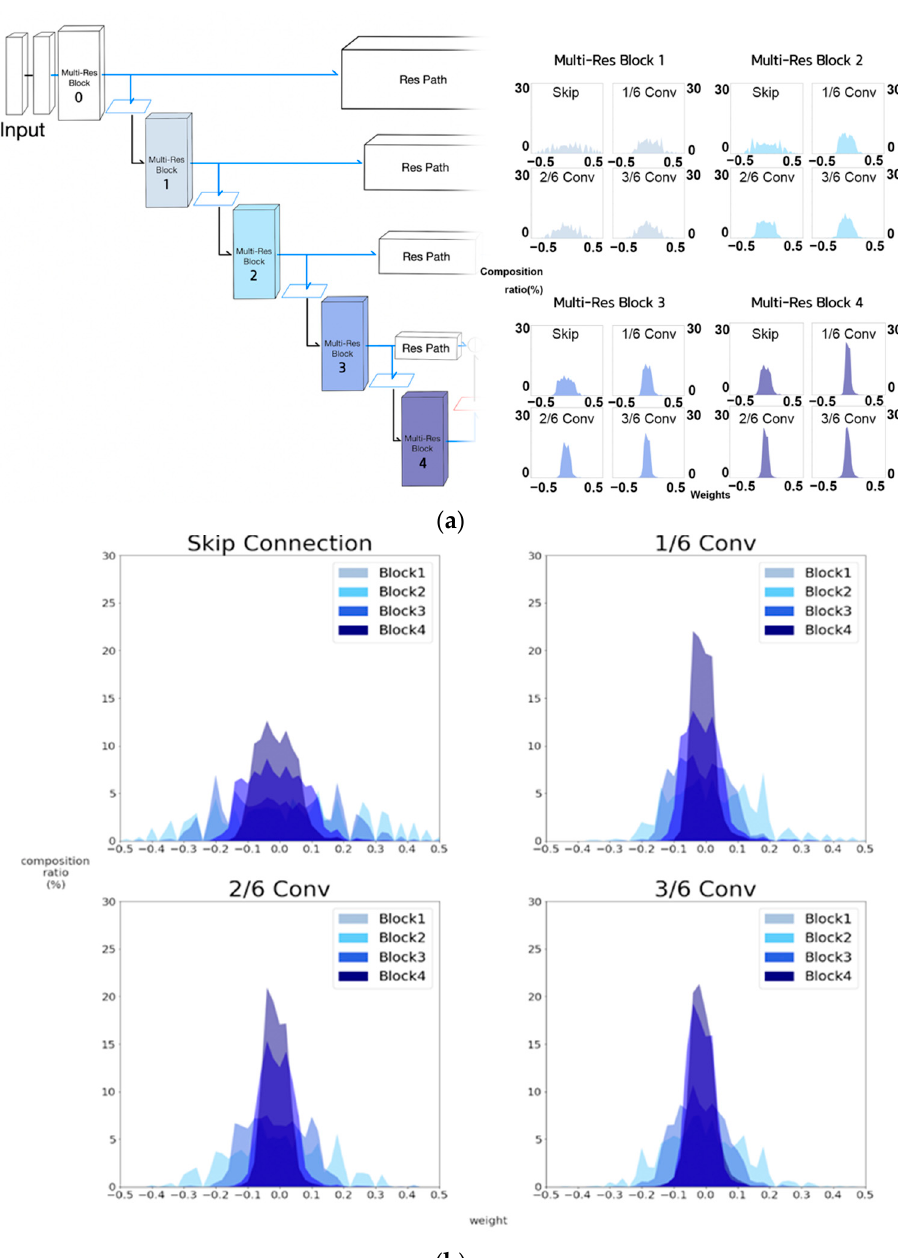
Figure 12. Weight histograms of MultiRes blocks of MultiResUNet. ( a ) Weight histograms of layers within MultiRes blocks 1, 2, 3, and 4. ( b ) Overlapped weight histograms for each component of MultiRes blocks 1, 2, 3, and 4.